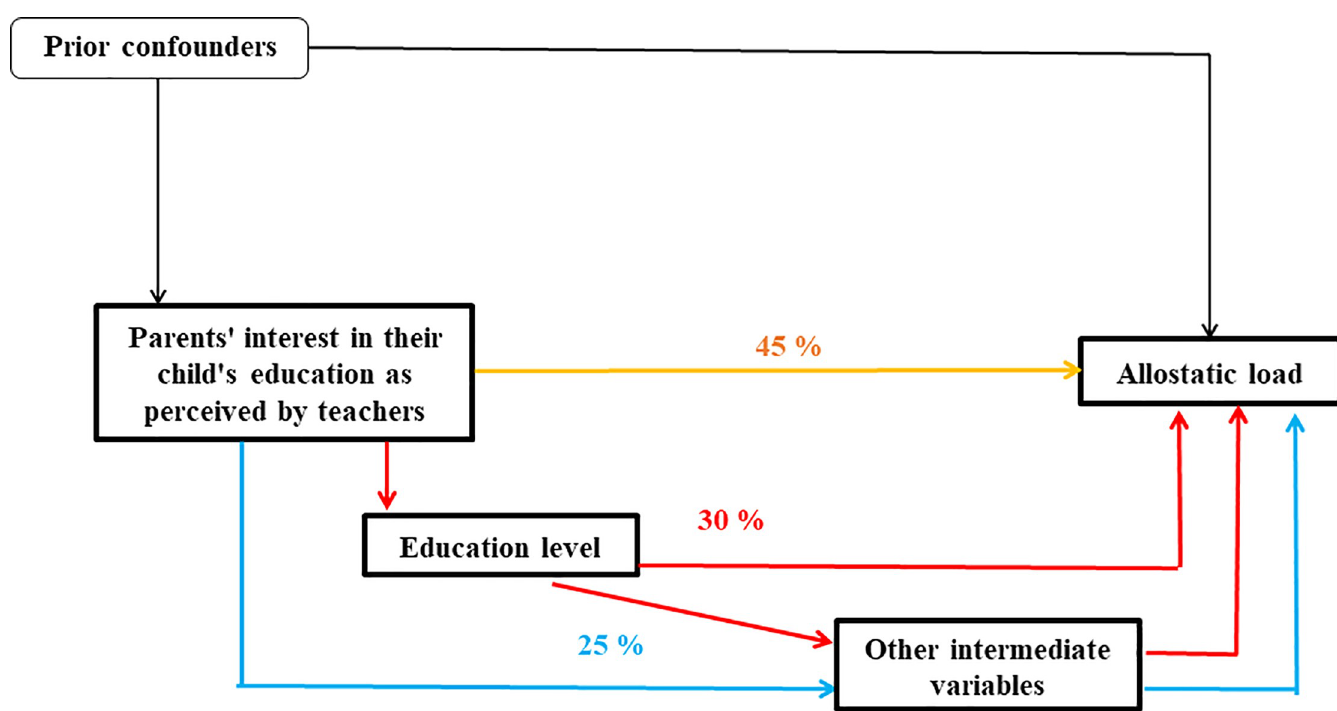
Fig 3. Direct and indirect effect results between parental interest and allostatic load obtained from multiple imputation for women (n = 4